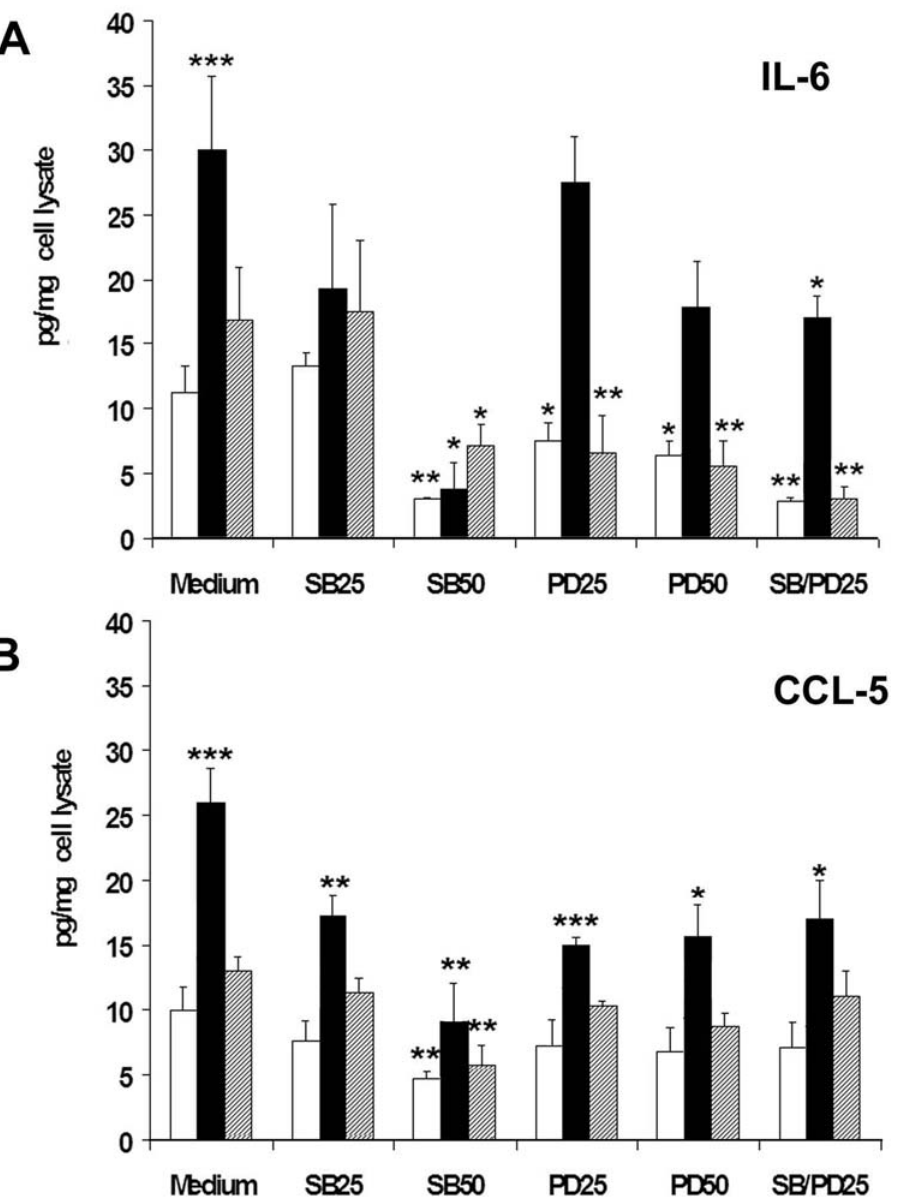
Figure 4. Inducing activity of PSMA cross-linking on IL-6 and CCL5 expression and role of PSMA-activated p38 and ERK1/2 . IL-6 (panel A) and CCL5 (panel B): production by LNCaP cells left untreated (open bars), stimulated by cross-linking via anti PSMA mAb (filled bars) or anti- VCAM-1 mAb (dashed bars) in the presence or in the absence of single or combined inhibitors (SB and PD) at the indicated doses (SB50=50 m g/ml, SB25=25 m g/ml; PD50=50 m g/ml, PD25=25 m g/ml; SB/PD25=combinations of SB + PD at 25 m g/ml each). Control and treated cell cultures were washed, cultured for further 24 h before collecting cells and cell-free supernatants. IL-6 and CCL5 accumulation in each supernatant was measured by ELISA and expressed as pg/mg of cell lysates/24 h. Inhibitors were added to the cells 6 h prior to stimulation and maintained throughout the duration of the experiment. Values represent the mean 6 SEM of results of four experiments performed in duplicates. Stars on top of the bars indicate statistical significance as follows: p , 0.001, ***; p , 0.01, **; p , 0.05,